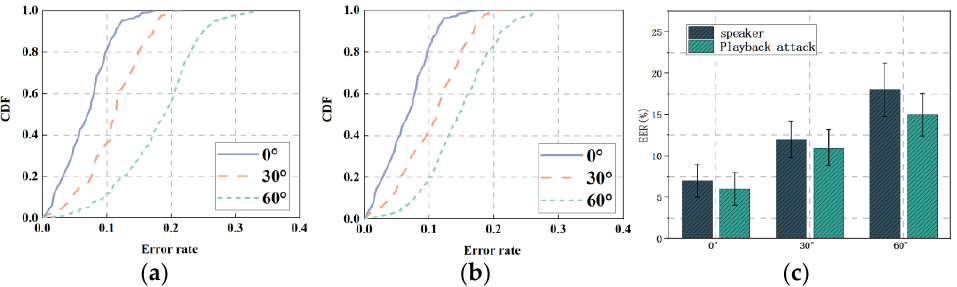
Figure 9. Different arrival angles: ( a ) CDFs (speaker); ( b ) CDFs (playback attack); ( c ) EER.